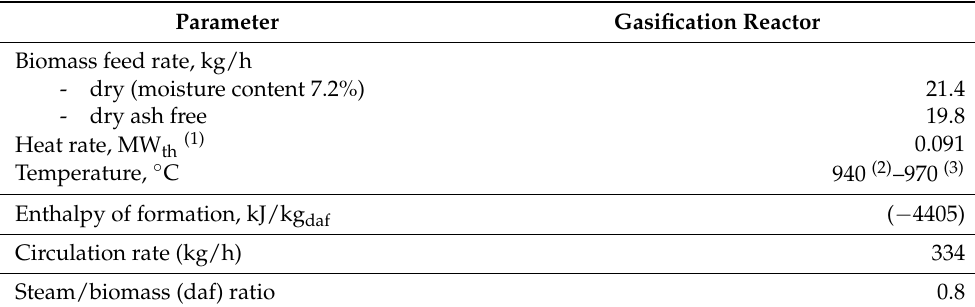
Table 7. Operational parameters of the novel DFB gasifier [29,30].